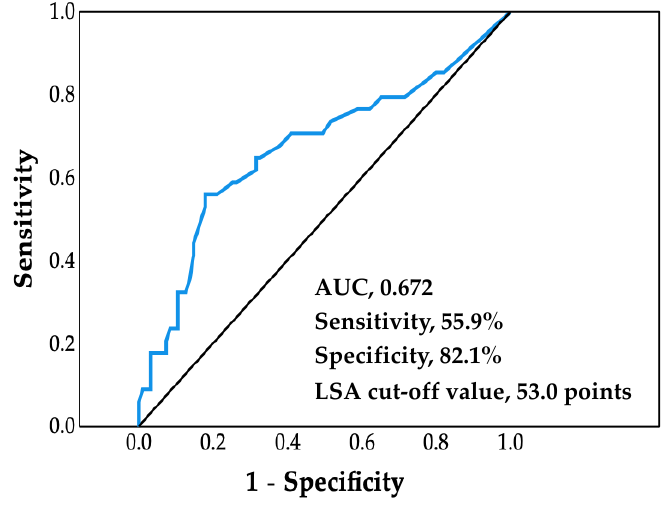
Figure 1. Receiver operating characteristic curve. Life-space assessment (LSA) cutoff value was determined by using the maximum value of the Youden Index. AUC, area under the curve.